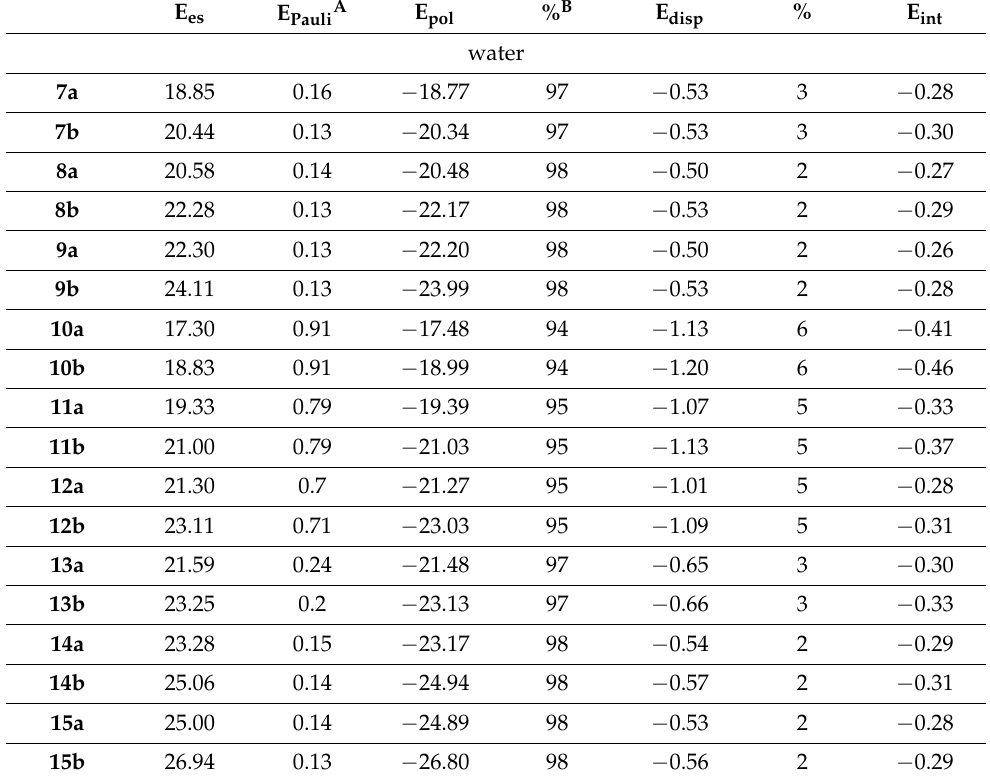
Table 9. LMOEDA/MP2/aug-cc-pVDZ decomposition of the interaction energy in water of com- plexes into electrostatic (E es ), repulsion (E rep ), exchange (E ex ), polarization (E pol ) and dispersion (E disp ) components. All quantities in